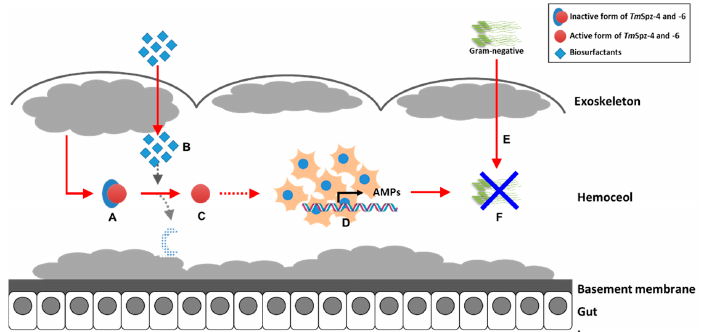
Figure 11. Proposed graphic summary of biosurfactants activity in the expression of AMPs through activation of TmSpz-4 and -6 . The pro-form of Tm Spzs (A) generated from fat body is activated by the injection of biosurfactants (B) to matured form of Tm Spzs (C). The activated Tm Spzs initiate the activation of intracellular toll signaling cascade in hemocytes to produce several AMPs (D), and when E. coli is injected into the T. molitor hemoceol (E), the produced AMPs protect the host from infection ( F ). Author Contributions: Y.S.H. and Y.H.J. conceived and designed the experiments; Y.S.H., and Y.H.J. contributed reagents/materials/analysis tools; T.T.E. and M.K., performed the experiments; T.T.E. and Y.H.J., analyzed the data; T.T.E., wrote the first draft of the manuscript; T.T.E., Y.H.J. and Y.S.H., I.S.K. revised and edited the manuscript. All authors have read and agreed to the published version of the manuscript.